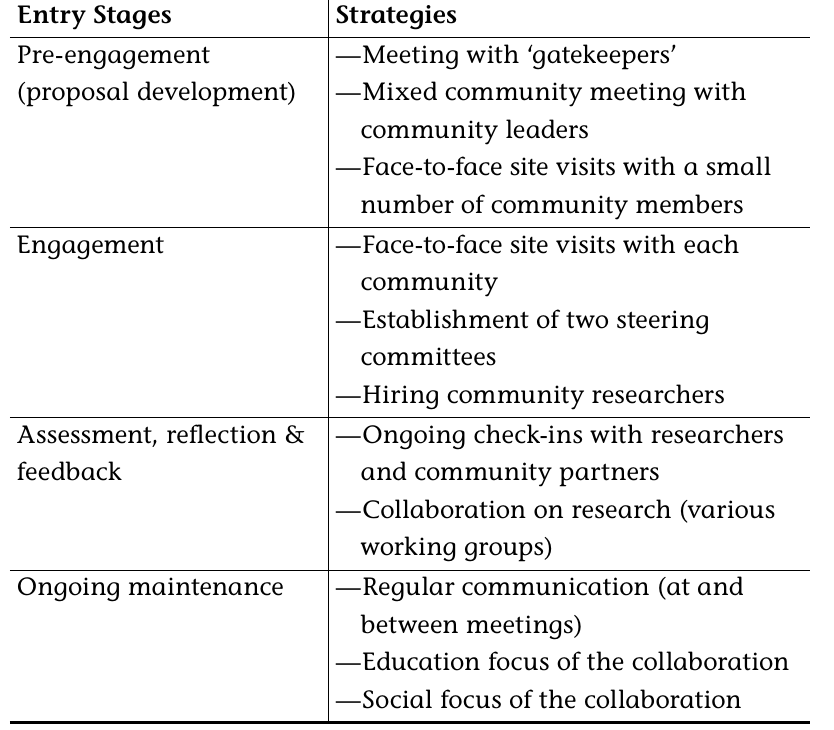
Table 1: Summary of strategies for each entry